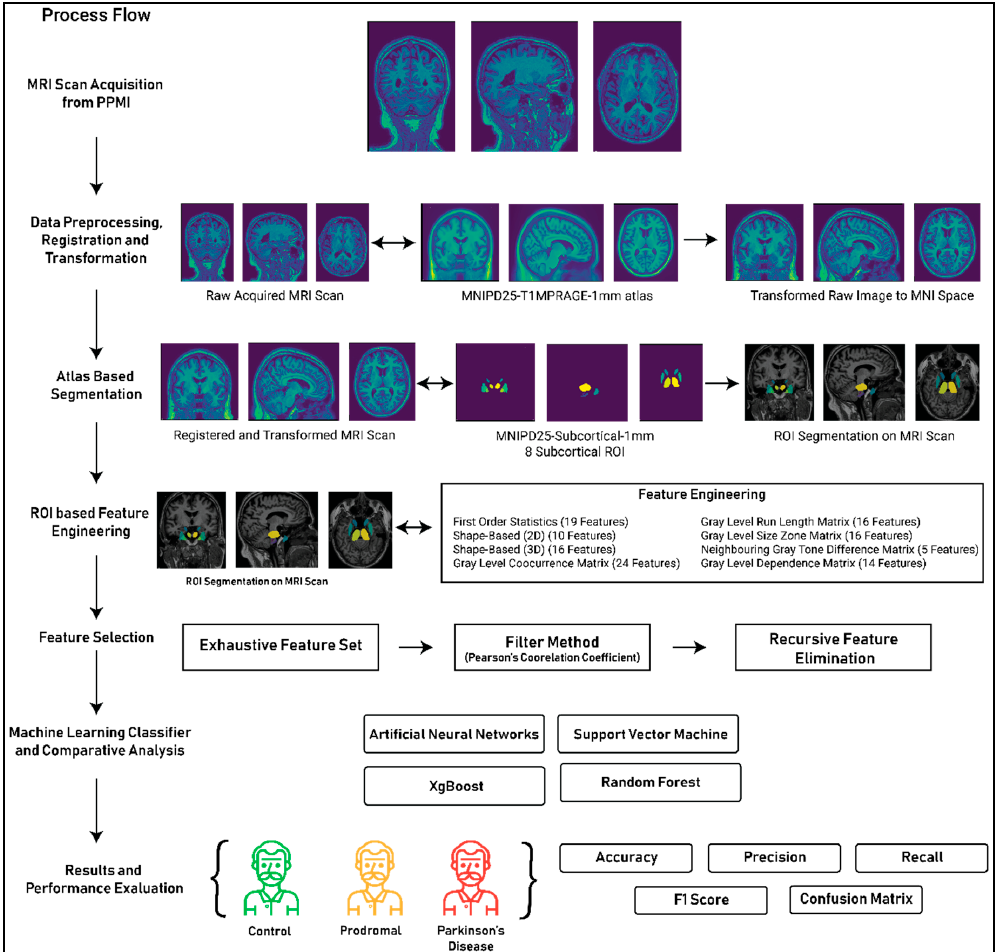
Figure 3. Complete process flow of the study.